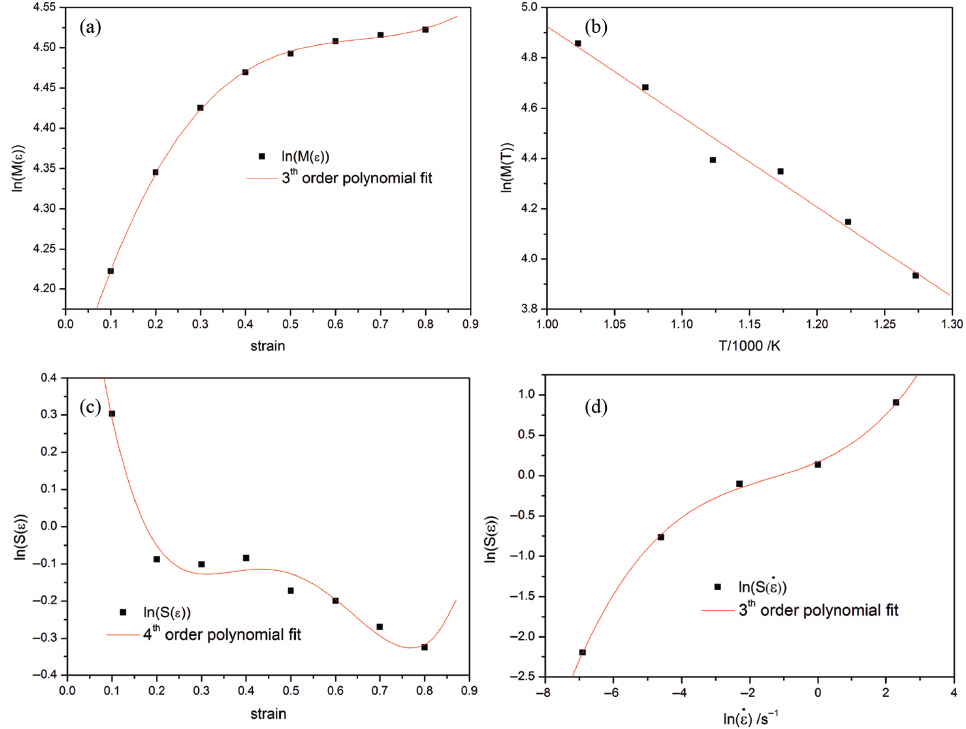
Figure 13: ln( M ), ln( S ) changing with strain, strain rate and temperature: (a) ln( M ( ε )); (b) ln( M ( T )); (c) ln( S ( ε )); (d) ln( S ( _ ε